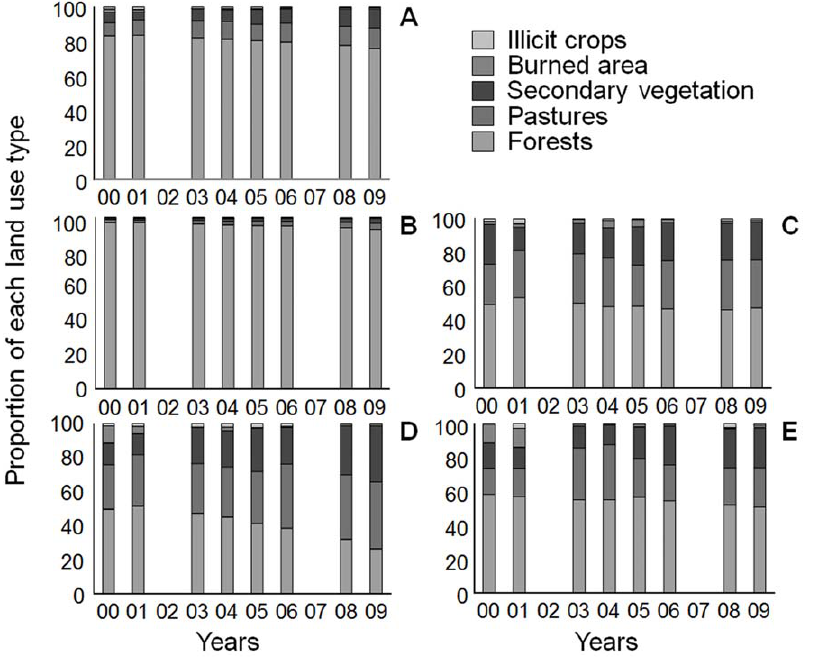
Figure 4. Proportion of each land use type over time in windows of all mosaics. (A); Forest mosaics (B); Pasture mosaics (C);Fire mosaics (D); and Illicit crop mosaics (E).